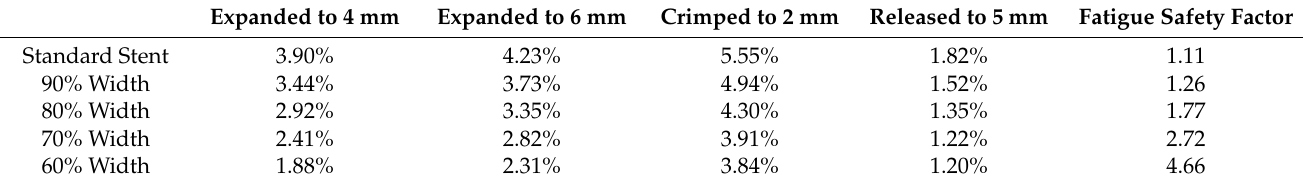
Table 1. Maximum strains and fatigue safety factor as a function of the strut tapered degree.